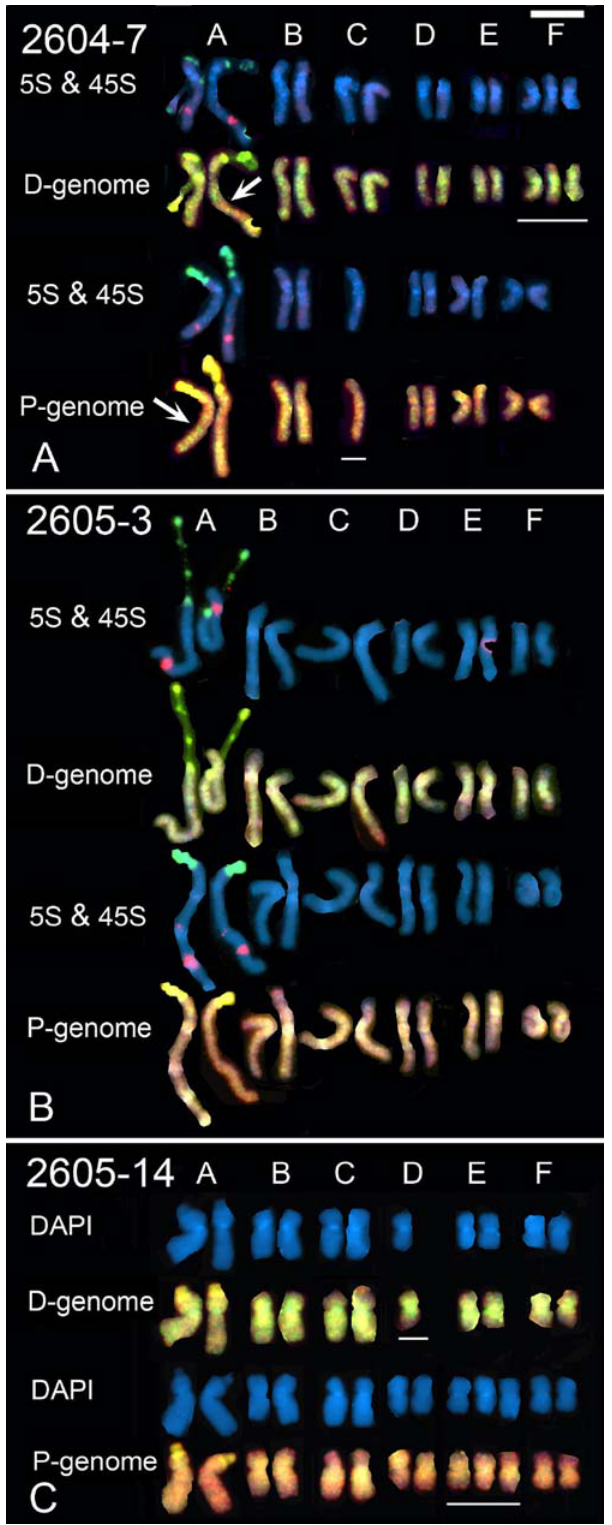
Figure 3. (A–C) Karyotype analyses of T. miscellus from two populations (A) 2604 and (B) 2605. Homeologous chromosome group nomenclature (A–F) follows Ownbey and McCollum [25] and Pires et al . [24]. Fluorochrome colours and probes are as in Figure 2 except that biotinylated T. pratensis genomic DNA was used in GISH experiments. Monosomic and trisomic chromosomes are underlined.